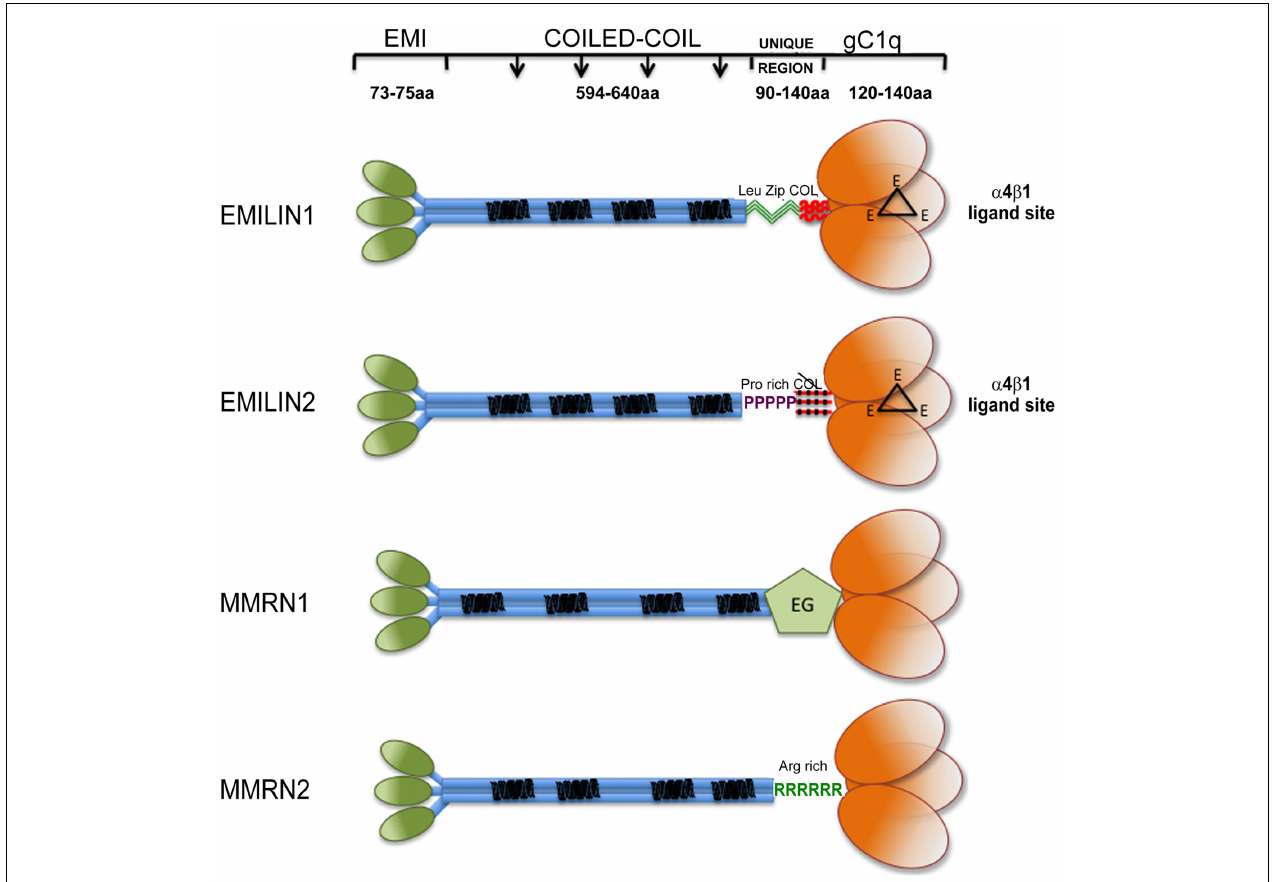
is represented in EMILIN1 by two leucine zippers followed by a functional 17 triplets long collagenic sequence; in EMILIN2 by a proline rich sequence followed by a non-functional 17 triplets long collagenic sequence; in MMRN1 by an arginine rich sequence; in MMRN2 by an EGF-like domain; (iv); the gC1q of EMILIN1 and EMILIN2 possess three unstructured loops (black triangles) each bearing a glutamic acid (E) able to interact with the α 4 β 1